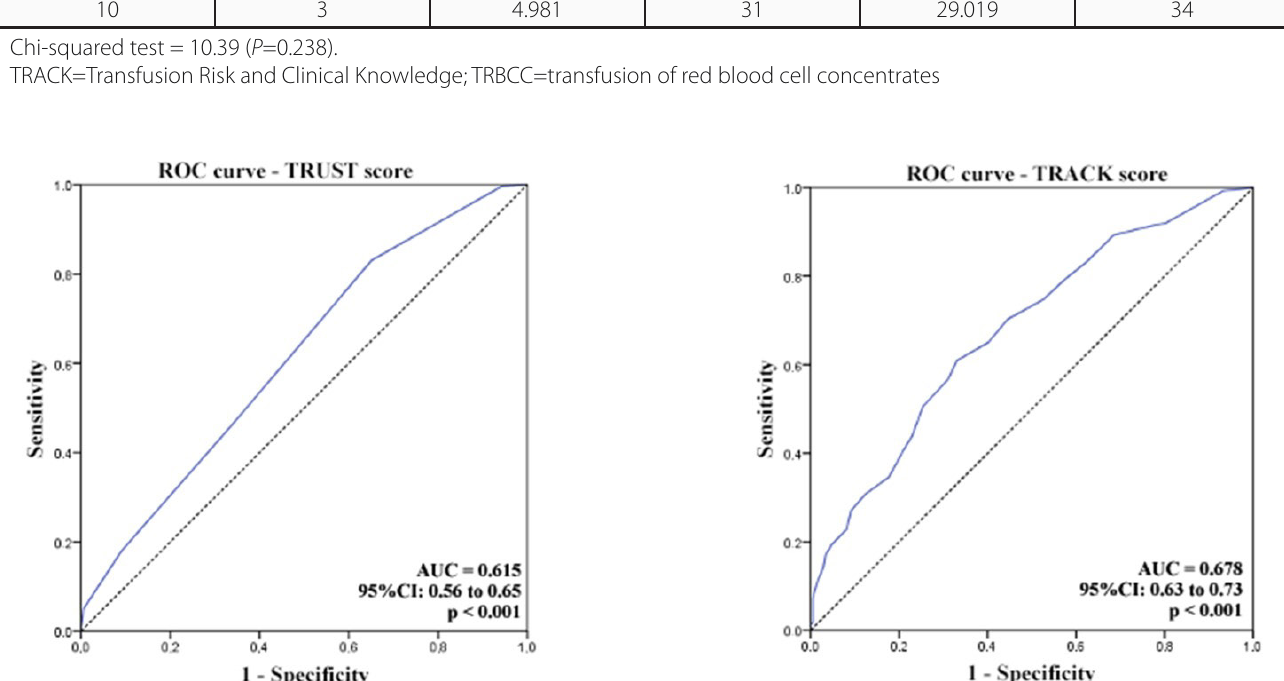
Chi-squared test = 10.39 ( P =0.238).